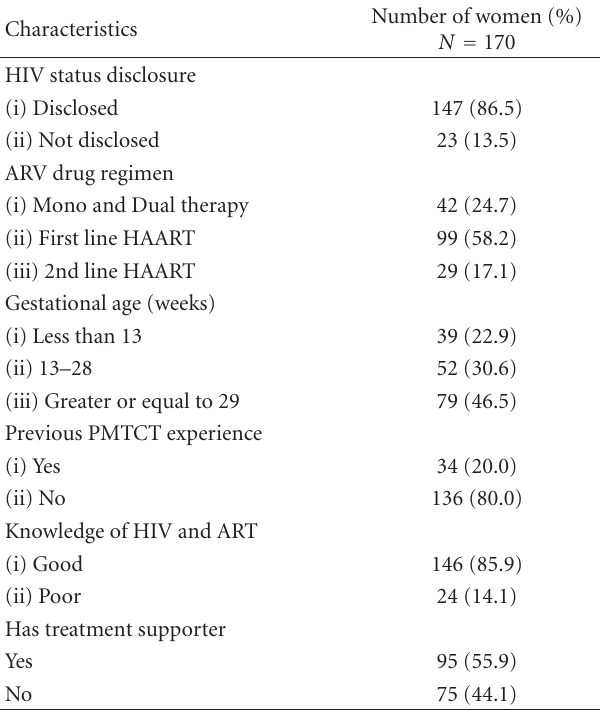
Table 2: The distribution of pregnancy and HIV related character- istics of the women enrolled in the study.